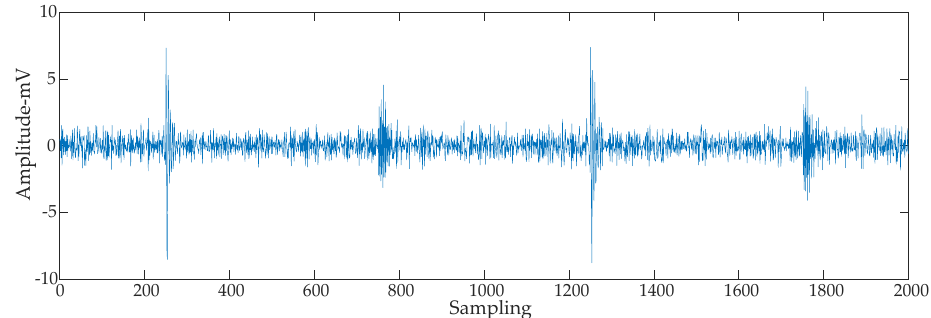
Figure 12. White noise interference suppression achieved by the EMD method.